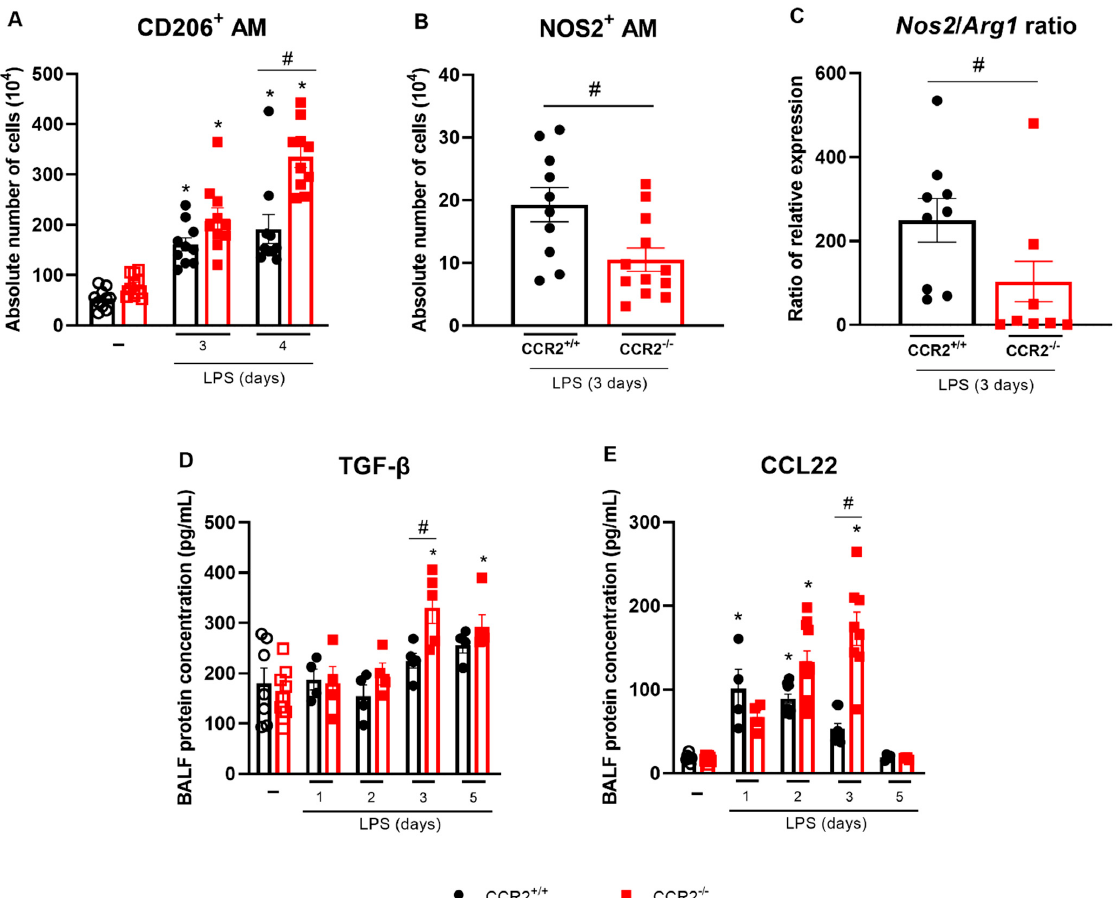
Figure 6. CCR2 deficiency is associated with the increase of molecules related with M2 macrophages. CCR2 +/+ (black symbols) and CCR2 − / − (red symbols) C57BL/6 mice were challenged with